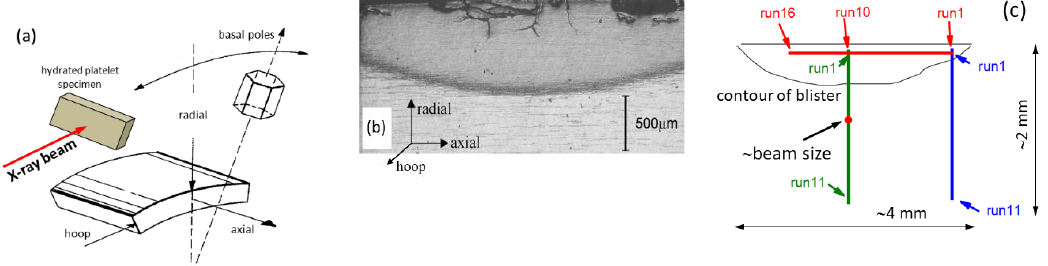
Figure 8. ( a ) Schematic configuration of the hydrated platelet sectioned from a CANDU pressure tube. The conventional coordinate system with the residual stress directions, radial, axial, and hoop strain/stress directions, along with the typical basal pole directions in the textured Zr tube material, is also indicated. ( b ) Optical micrograph of the hydrated Zircaloy-4 platelet. The darker region is the